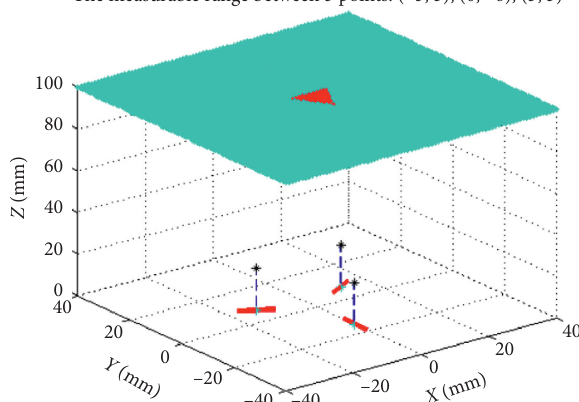
Figure 4: Measurable range on the z � 100mm plane.